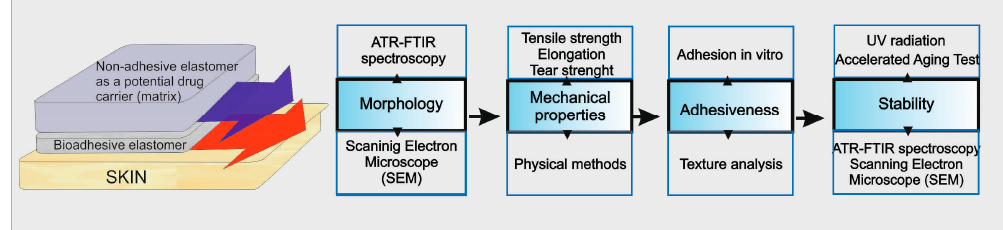
Figure 1. Algorithm of the procedure applied for the physical and mechanical characterisation and stability assessment of the adhesive silicone film double-layer adhesive silicone film (DLASil).